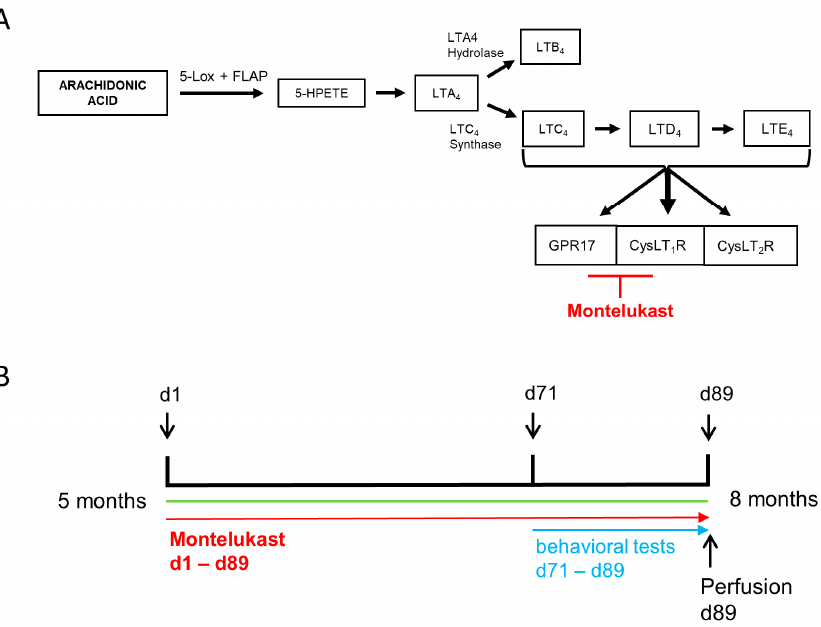
Figure 1. ( A ) The leukotriene signaling pathway. Leukotrienes arise from arachidonic acid (AA), which is converted to LTA4 by the enzyme 5-Lipoxygenase (5-Lox) and its activating protein (FLAP). LTA4 is either metabolized to LTB4 by LTA4 hydrolase or to LTC4 by LTC4 synthase. From LTC4, the other cysteinyl leukotrienes, i.e., LTD4 and LTE4, arise. Cysteinyl leukotrienes bind to the receptors CysLTR1, CysLTR2 and GPR17. Leukotriene signaling can be inhibited by targeting the receptors for cysteinyl leukotrienes with the leukotriene receptor antagonist montelukast. ( B ) Experimental setup. Five-month-old 5xFAD transgenic mice were treated daily with vehicle or montelukast in two different doses for 89 days. Behavioral tests were performed between day 72 and day 89. On the last day of the behavioral tests, the mice were perfused, and tissue samples were collected.